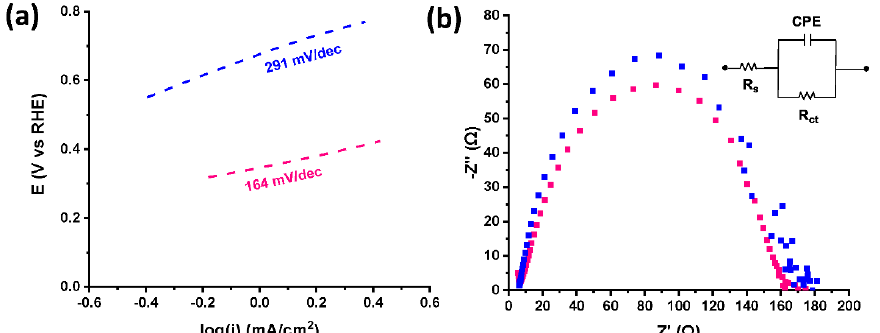
Figure A4. ( a ) Tafel slope [Co]-pyr-graphene (pink) and [Co]-imi-graphene (blue) after 10,000 catalytic cycles. The LSVs were obtained at 1600 rpm rotation speed and 5 mV/s scan rate in N 2 -saturated aqueous 0.5 M H 2 SO 4 . The current densities are normalized to the geometric electrode area. ( b ) Nyquist plots of [Co]-pyr-graphene (pink) and [Co]-imi-graphene (blue) after 10,000 catalytic cycles. Inset: Equivalent circuit used for fitting the EIS data. Rs refers to the overall series resistance, Rct to the charge transfer resistance and CPE to the constant phase angle element, which represents the double layer capacitance of solid electrode in a realistic situation. The EIS measurements (Nyquist plots) were recorded at the low overpotential (kinetic) region.